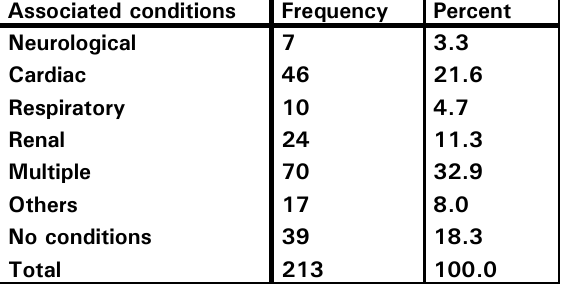
Table 6: Associated conditions with diabetes